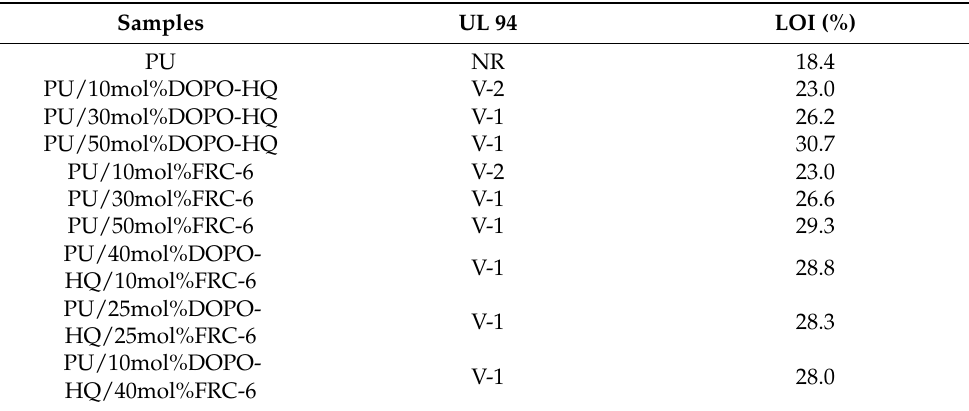
Table 4. LOI and UL 94 ratings of PU, PU/DH, PU/F, and PU/DH/F.